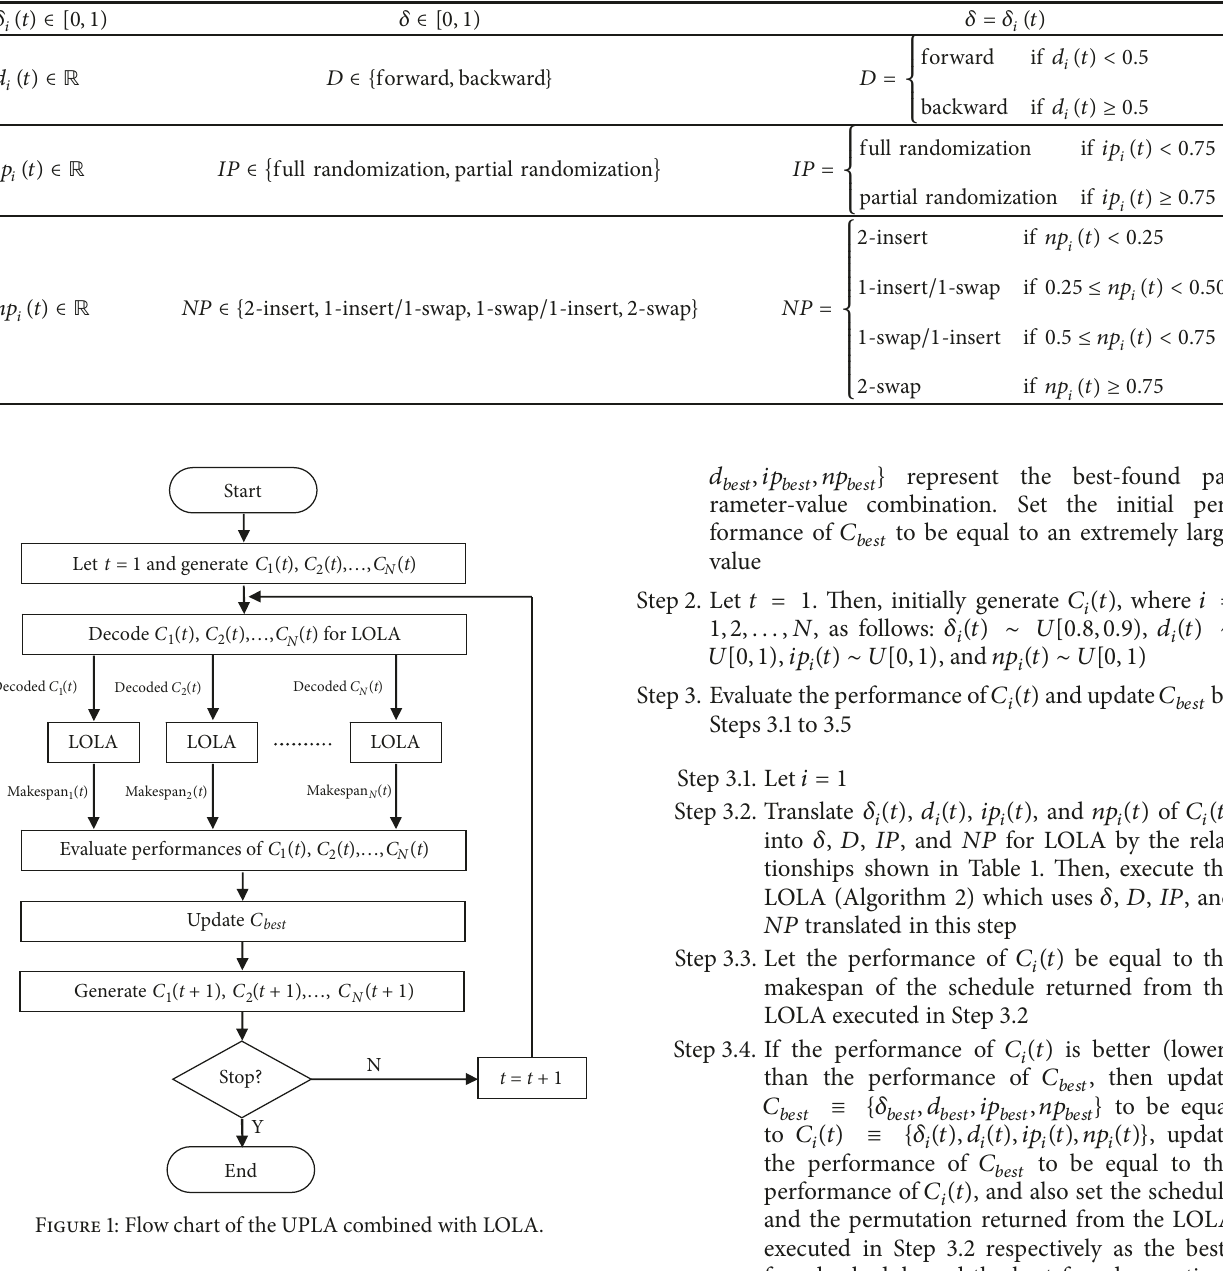
Table 1: Translation of 𝐶 𝑖 (𝑡) of UPLA into the input-parameter values of LOLA. UPLA LOLA Relationship